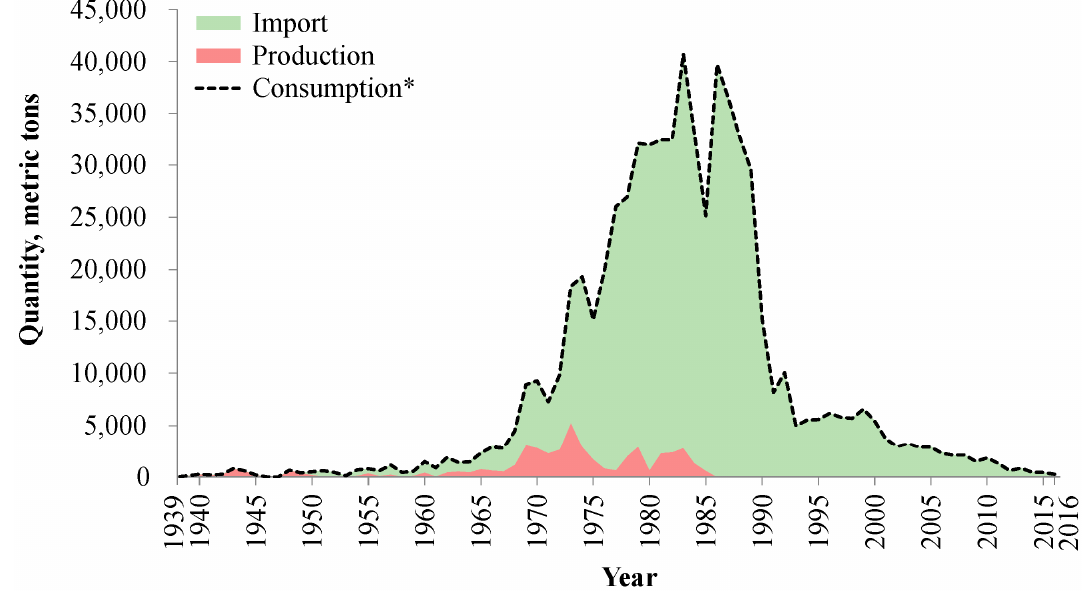
Figure 1. Trends of unmanufactured asbestos import, production, and consumption in Taiwan, 1930 to 2016 [5,15–19]. * Consumption = Production + Import.